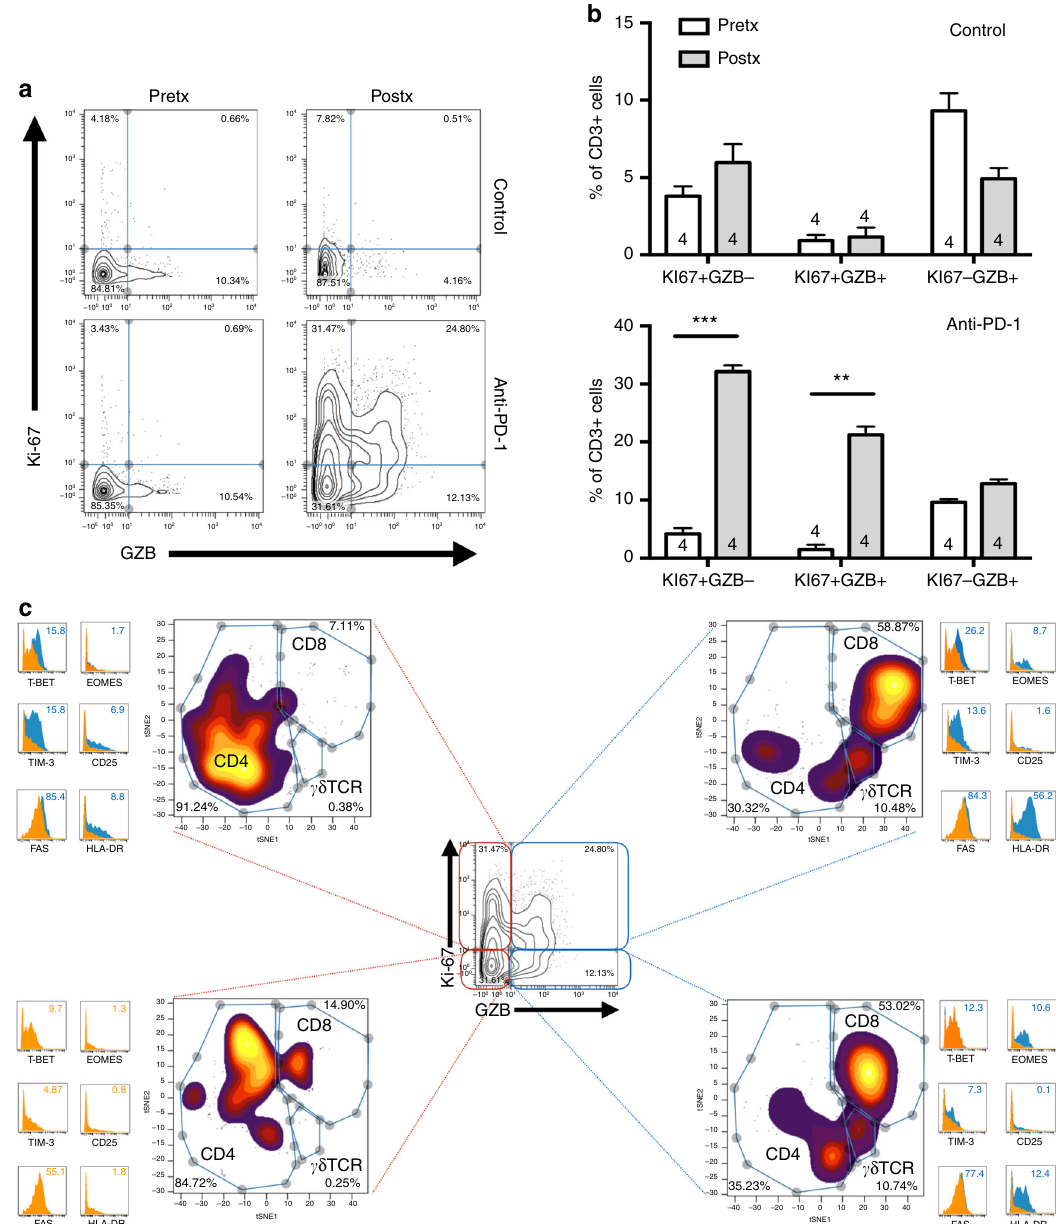
Fig. 6 T-cell reinvigoration with PD-1 blocking antibodies. Surgically resected primary NSCLCs were engrafted subcutaneously in the fl ank of NOD-scid IL2rgc-/- mice. Mice were treated intraperitoneally with anti-hPD-1 mAbs (anti-PD-1) or PBS (Control) at days 5 and 10. At day 12 mice were sacri fi ced and tumor tissues were mechanically digested and single cells studied by mass cytometry. a , b Representative graphs depicting the levels of Ki-67 and GZB expression in TILs (CD3 + ) before engraftment (Pretx) and at the moment of sacri fi ce (Postx) in control and anti-PD-1 treated tumor-bearing mice. Dot plot a is representative of four experiments shown in ( b ). Error bars indicate S.E.M. ** P < 0.01; *** P < 0.001, Mann – Whitney test. The number of independent experiments is indicated within the bars. c viSNE map of each biaxial plot of Ki-67 vs GZB quadrant. Three subpopulations were clustered using viSNE: CD4, CD8, and γδ TCR T cells. Expression pro fi le of each quadrant is depicted in small panels. Numbers indicate the median mass intensity for each marker. Expression of quadrant Ki-67-GZB- was used as a